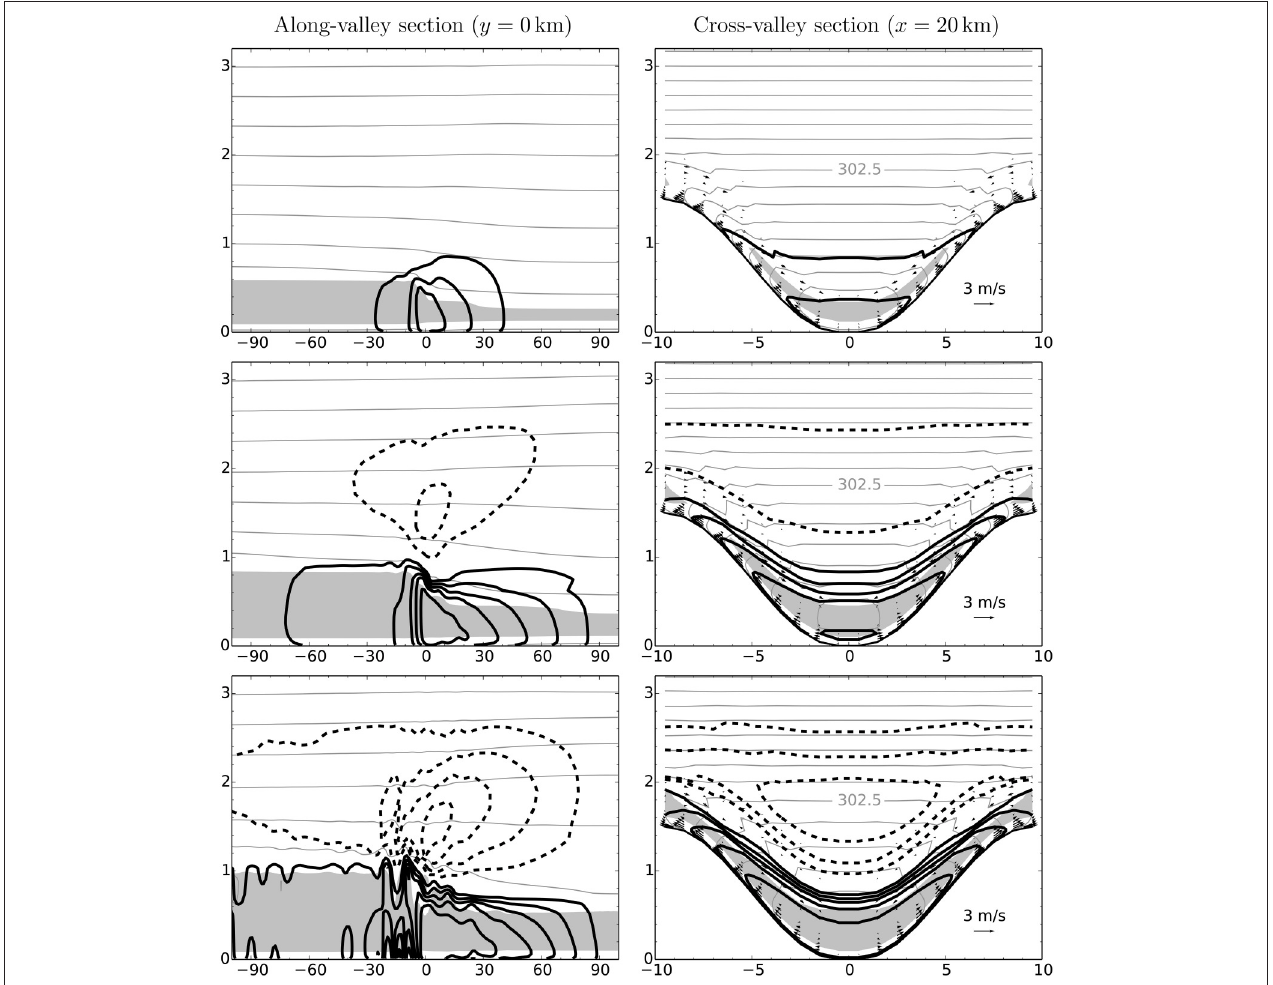
FIGURE 4 | Evolution of the valley wind system for the reference case. Along-valley and cross-valley sections after 3, 6, and 9h of integration showing the along-valley flow (thick contours; contour interval = 0.5ms − 1 ; negative values are dashed), potential temperature [contour interval = 1K (left panels) and 0.5K (right panels)], eddy diffusivity (shading; 10 m 2 s − 1 ), and the cross-valley circulation (wind vectors). The axis units are kilometers.